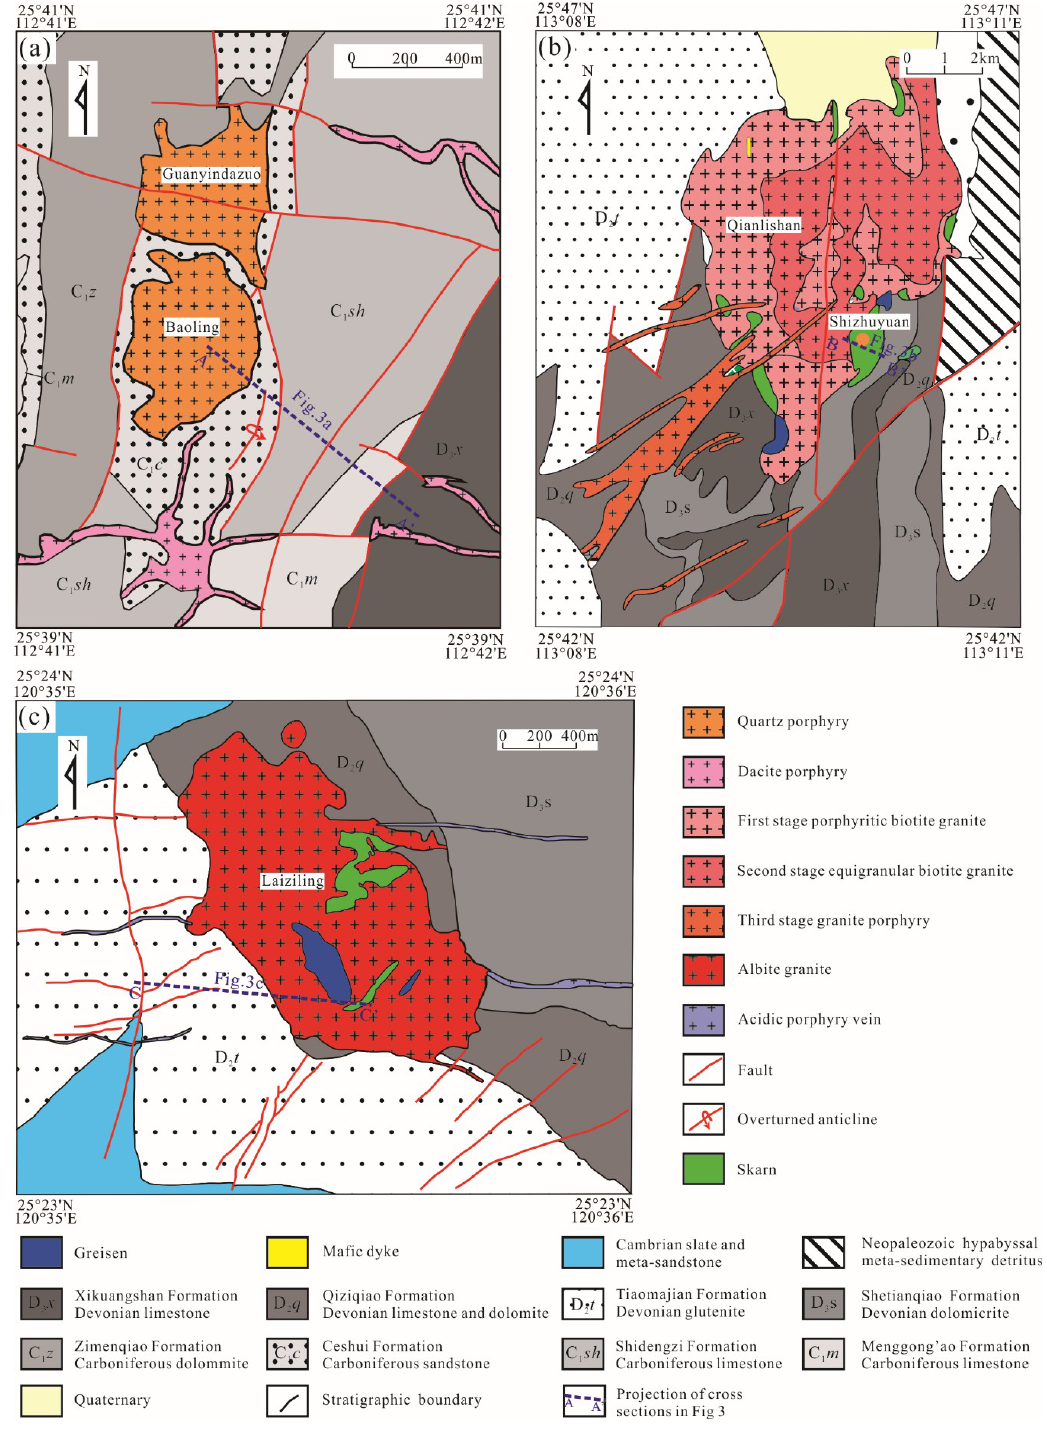
Figure 2. Geological maps of ( a ) the Huangshaping deposit (modified from [24]); ( b ) the Shizhuyuan deposit (modified from [68]); and ( c ) the Xianghualing deposit.